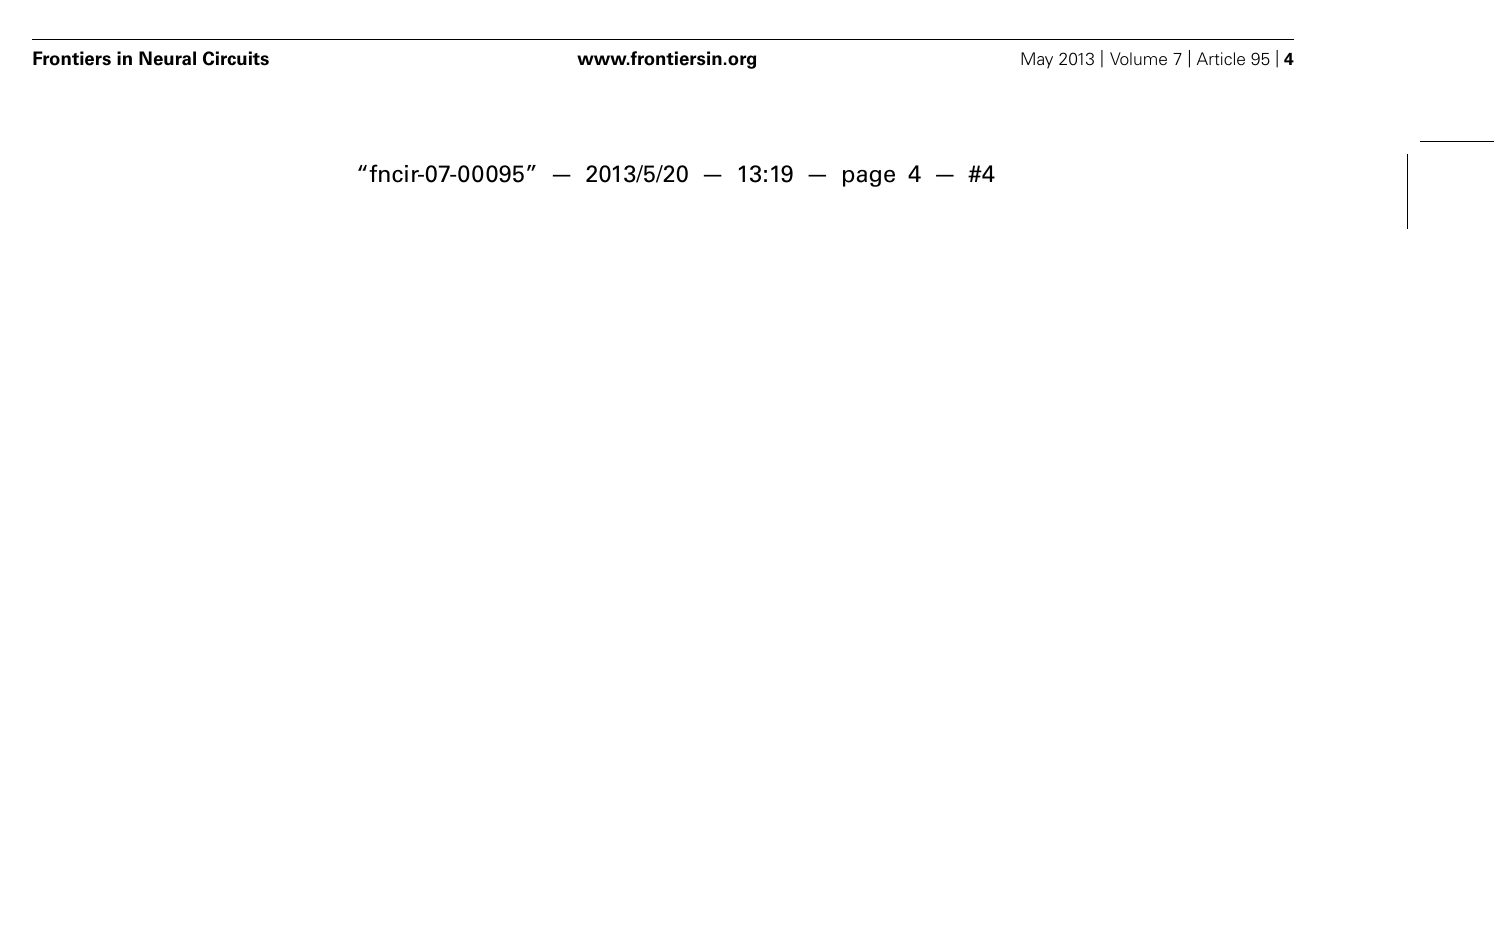
694 Hz and had an average firing frequency of 589 Hz. (D–F) Example of high-frequency GrC burst in the awake behaving mouse. (D) (top) Extracellular recording of granule cell in crus I of an awake mouse following whisker stimulation. Note absence of activity prior to movement onset, whereas a distinct, high-frequency burst occurs during stimulation. (E) Burst demarked in D shown at larger scale. Identified spikes are indicated by dots. (F) Instantaneous frequency plot of burst shown in E.This particular burst consisted of 21 consecutive spikes with instantaneous frequencies as high as 678 Hz and had an average firing frequency of 501